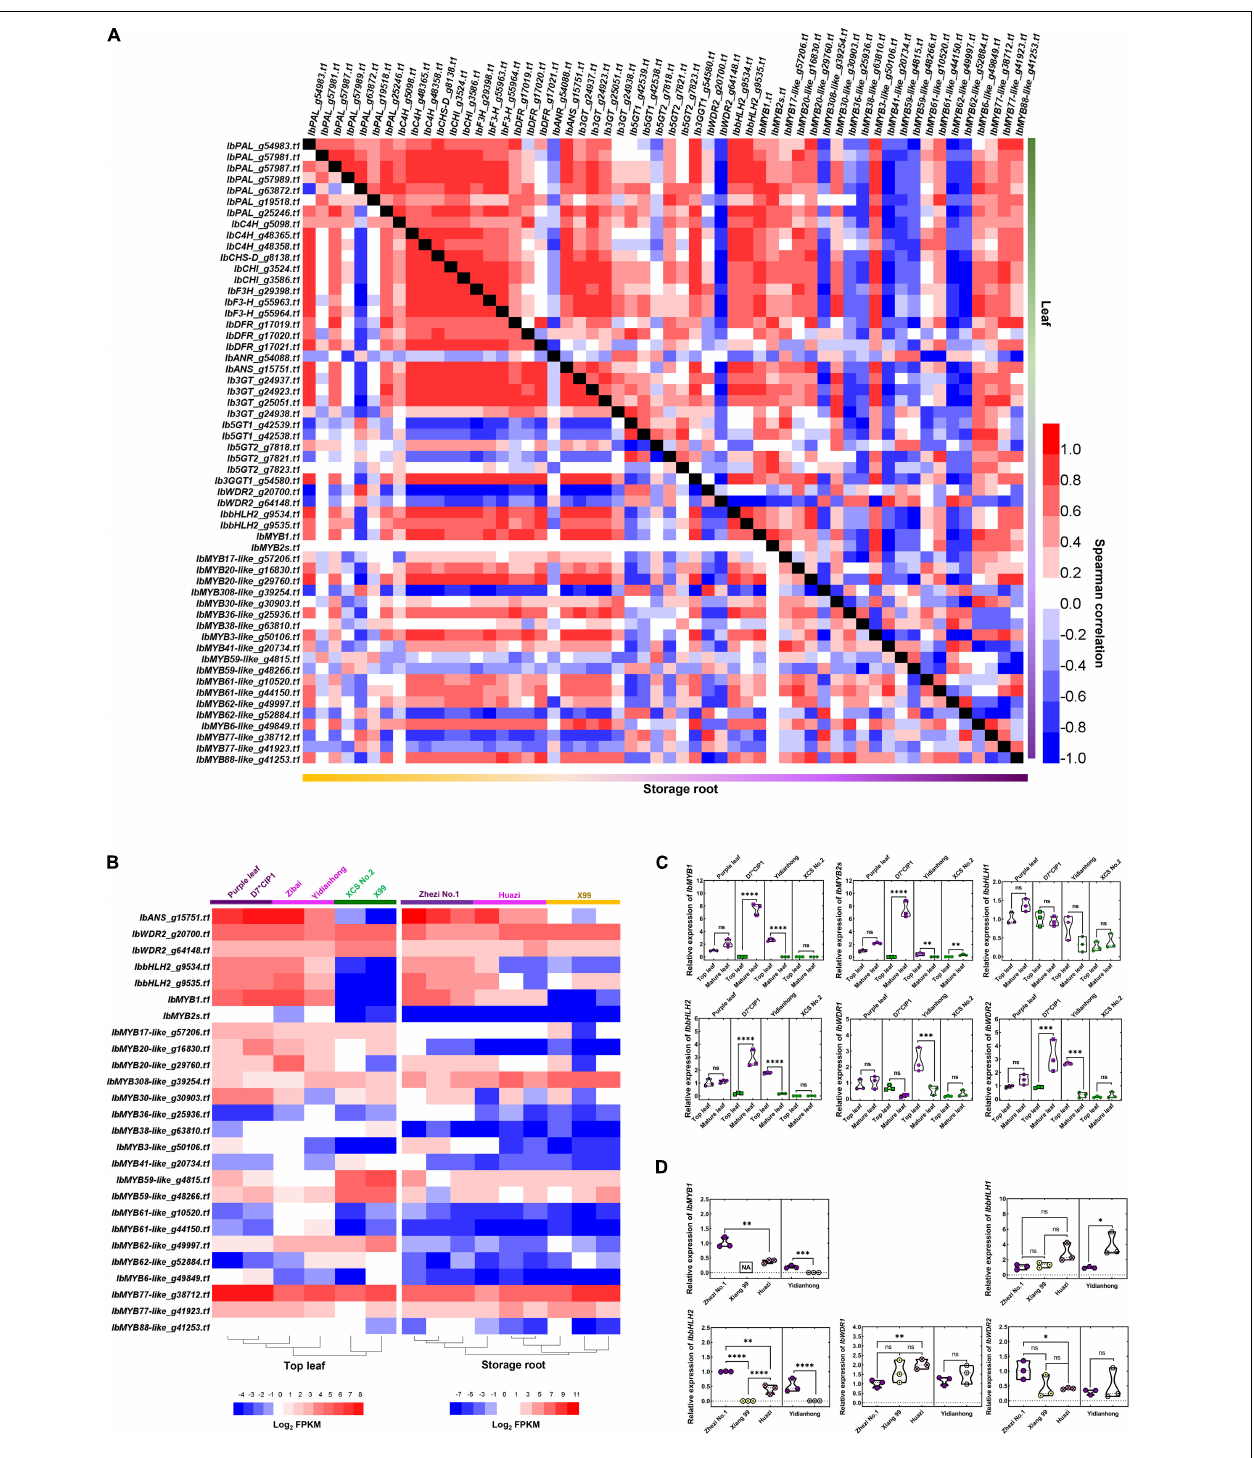
FIGURE 3 | Transcription factor (TF) expression difference of MYB-bHLH-WDR (MBW) complex related to anthocyanin biosynthesis. (A) Spearman’s correlation coefficient among the main genes related to anthocyanin accumulation in leaf and storage root by RNA-Seq. The triangle at the bottom represents the correlation of storage root, and the upper triangle represents the correlation of leaf. (B) Heatmap of DEGs related to MBW complex TFs in leaf and storage root by RNA-Seq. The color of the variety name and the lower horizontal line represents the color of the sample. (C) MBW complex TFs expression comparisons between top leaf and mature leaf of varieties by RT-qPCR. (D) TFs expression comparisons between different colors of flesh by RT-qPCR. The purple flesh of “Yidianhong” and the non-purple flesh of “Yidianhong” were analyzed. The color of jitter in the violin plot represents the color of the corresponding sample. * P < 0.0332, ** P < 0.0021, *** P < 0.0002, and **** P < 0.0001; ns indicates P > 0.1234. n = 3. “NA” in the box indicates that gene expression was not detected in the